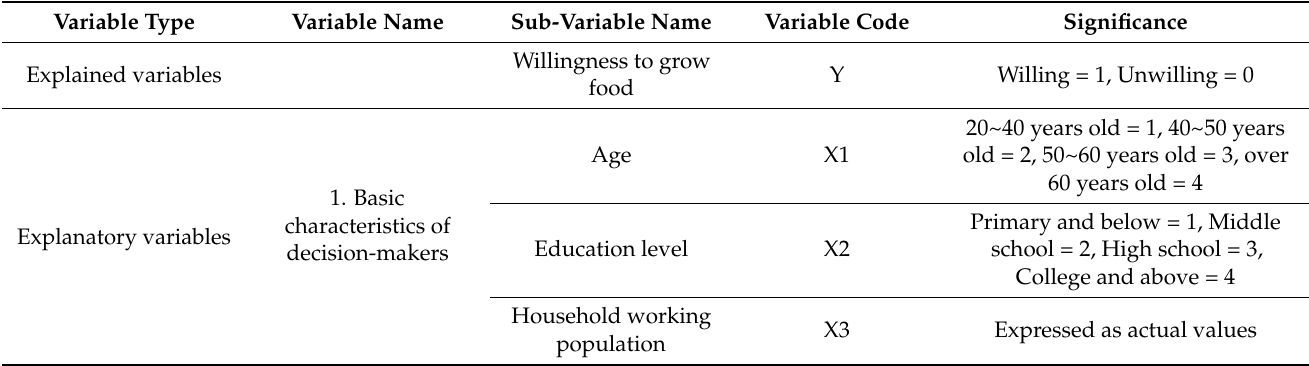
Table 1. Description of variables influencing farmers’ willingness to grow